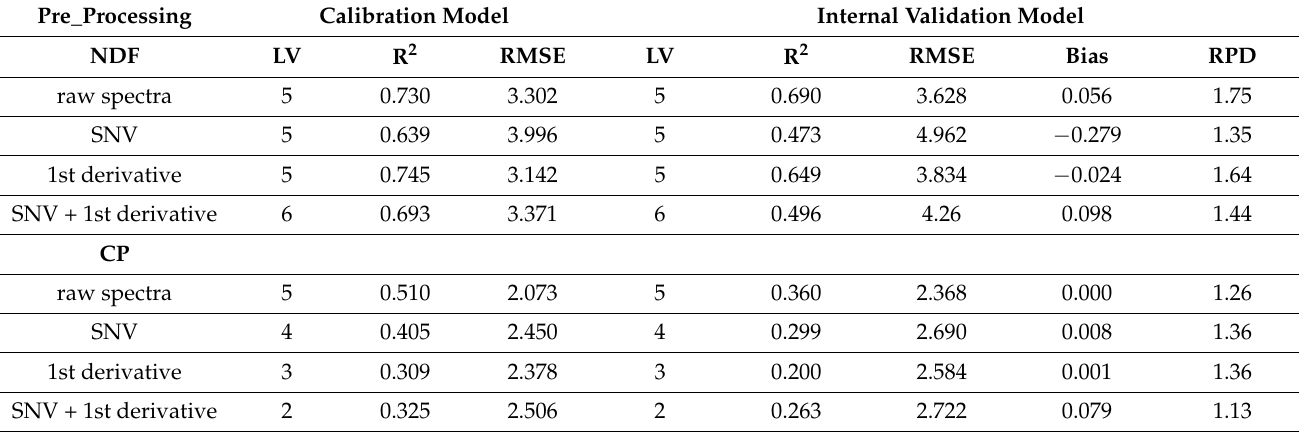
Table 2. Statistical indicators of the internal calibration and validation models for the NDF and the CP through the use of the micro NIR sensor in the pasture and partial least squares regression